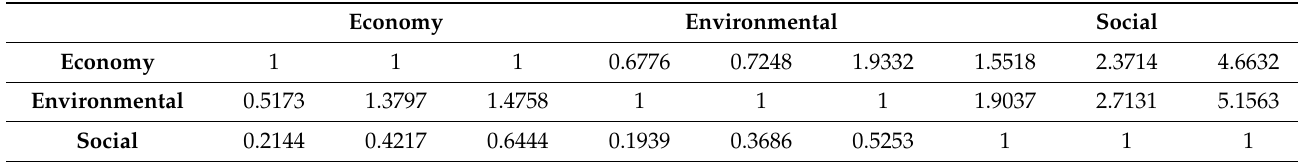
Table A2. Integrated Fuzzy Comparison Matrix Each Dimension.